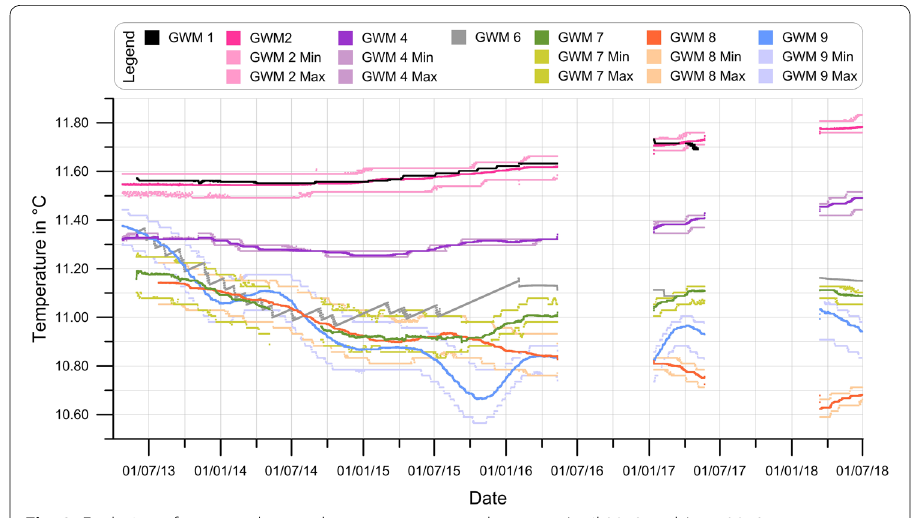
Fig. 3 Evolution of measured groundwater temperatures between April 2013 and June 2018